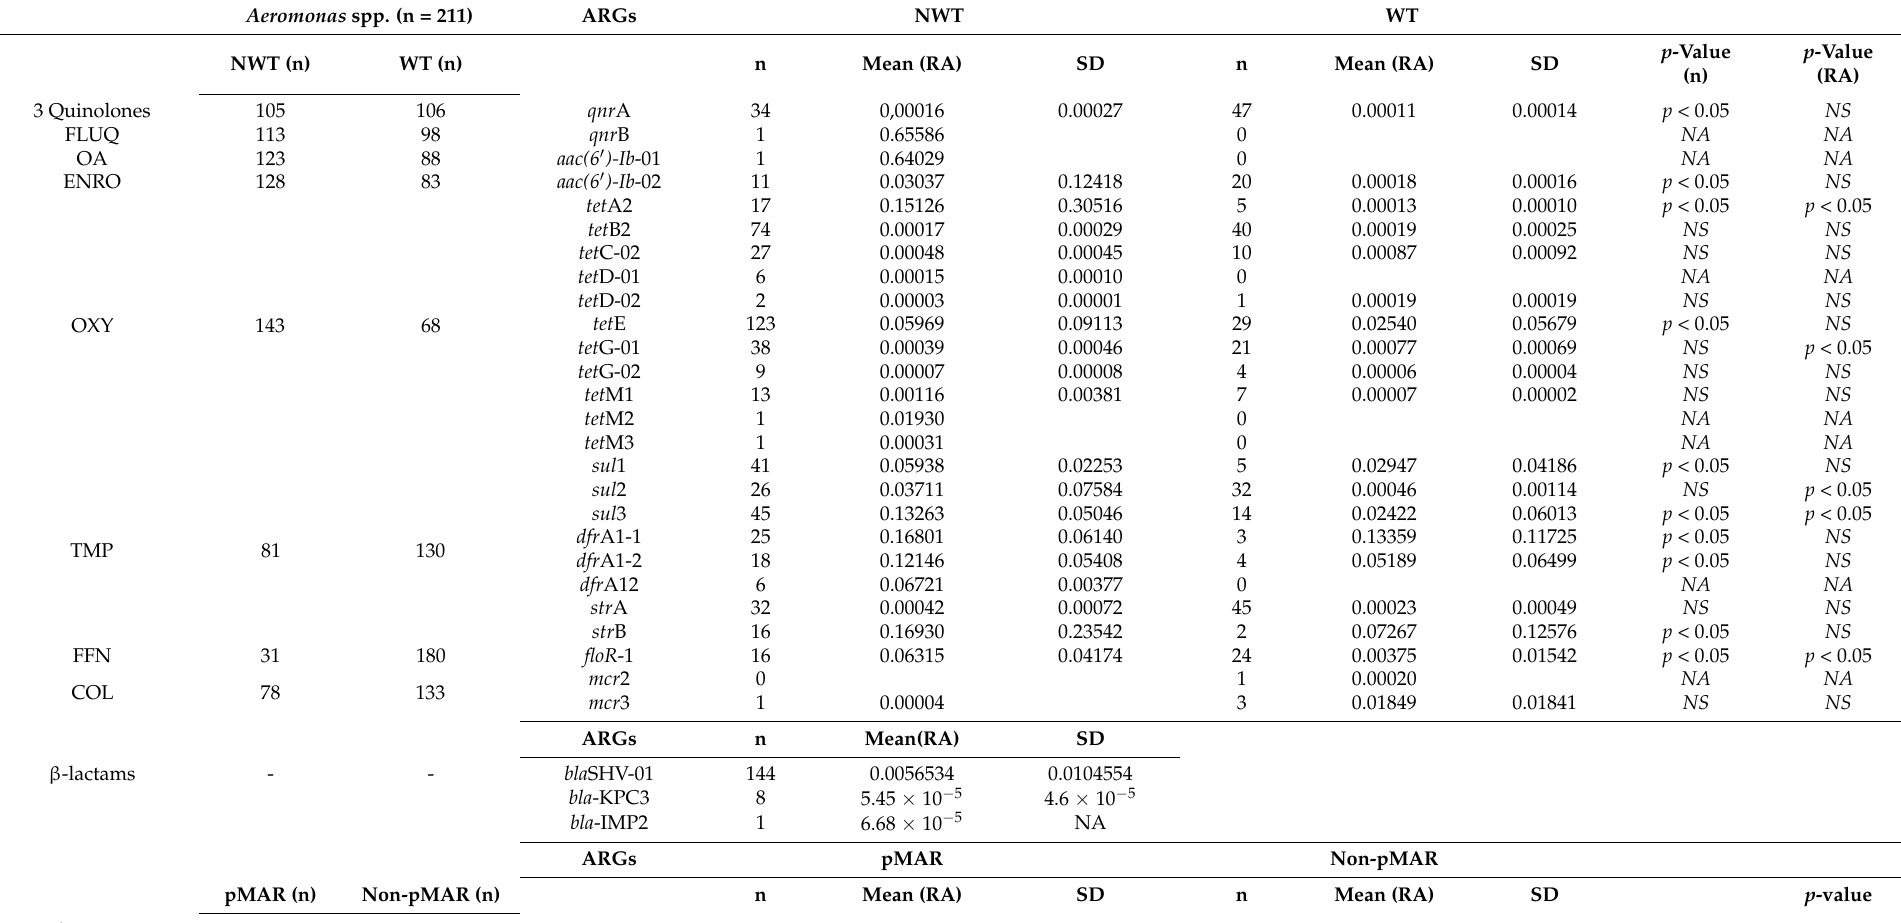
Table 3. The relative abundance (RA) (relative to the 16S rRNA gene) and distribution of antibiotic resistance genes (ARGs) in wild-type (WT) and non-wild-type (NWT) Aeromonas isolated from healthy, furunculosis-suffering and antibiotic-treated fish and their environment on two fish farms. FLUQ: flumequine; OA: oxolinic acid; ENRO: enrofloxacin; OXY: oxytetracycline; FFN: florfenicol; TMP: trimethoprim-sulfamethoxazole; COL: colistin; pMAR: presumptive multi-antibiotic-resistant Aeromonas; NS : not significant ; NA : not applicable